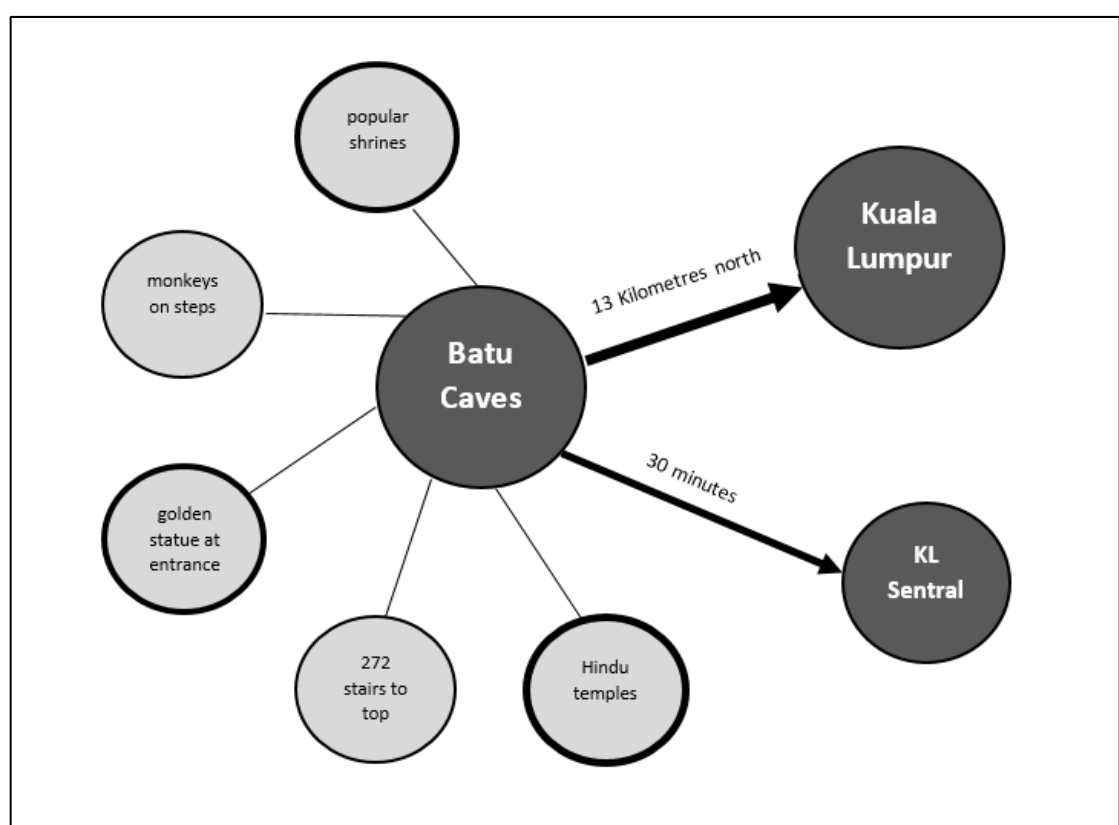
Figure 7. Multi-criteria-weighted POI graph for the case study POI, Batu Caves.